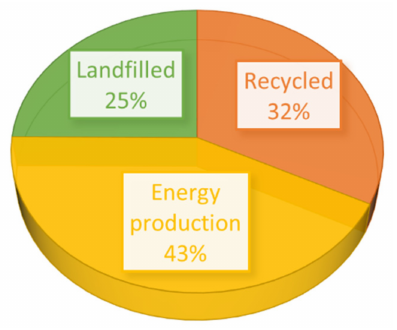
Figure 3. Reuse of recovered post-consumer plastic